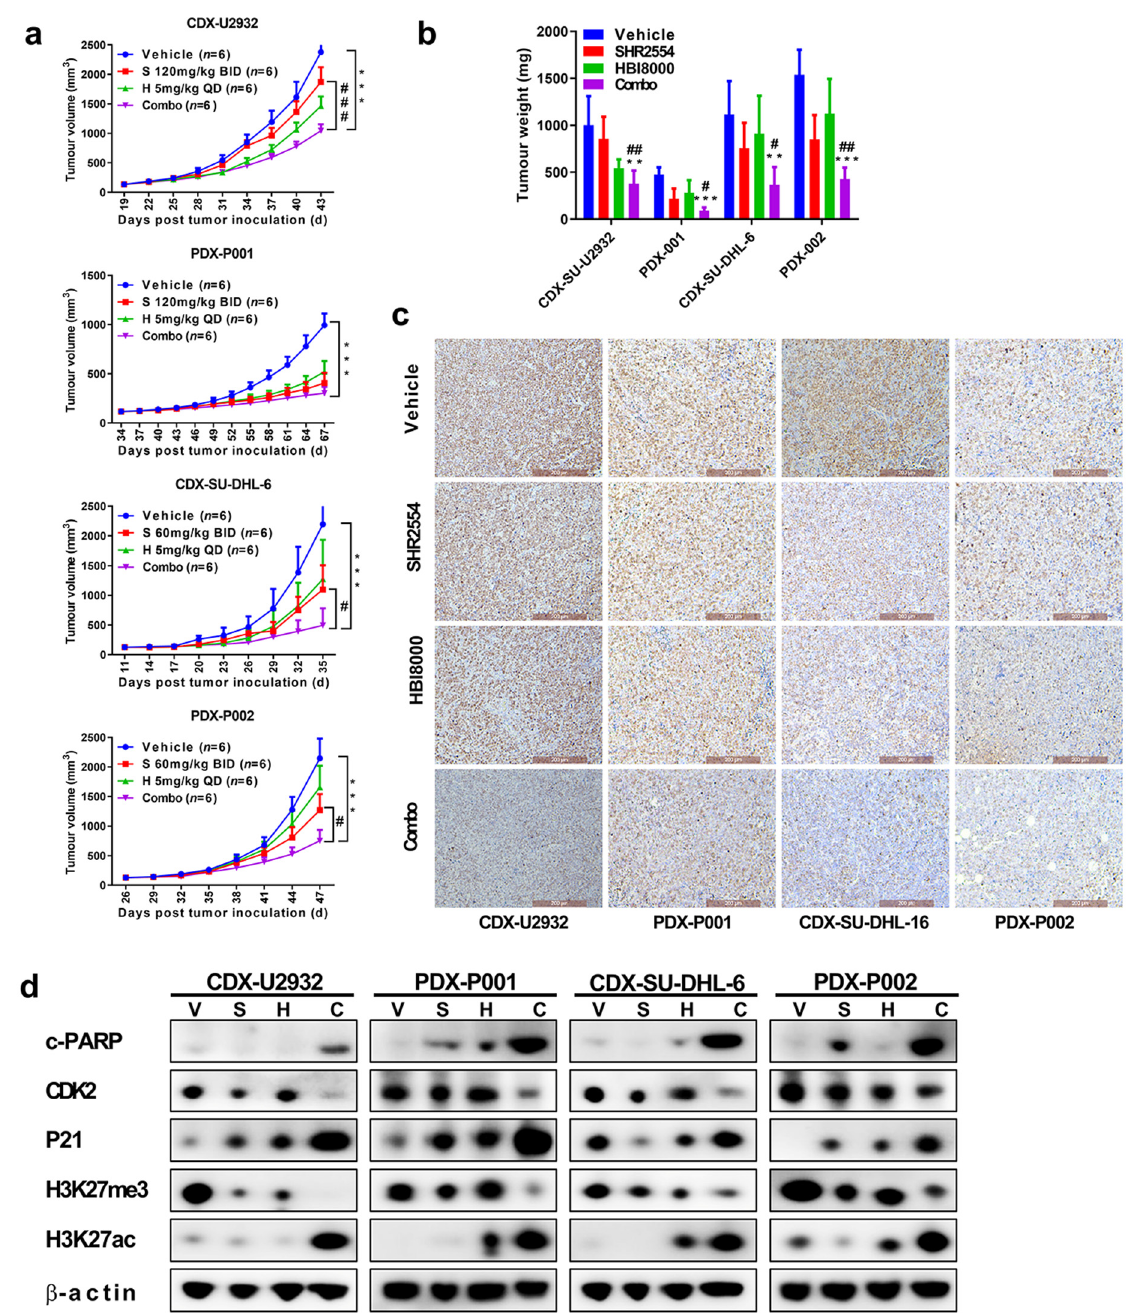
Figure 5. Combination of SHR2554 and HBI8000 exhibited synergistic anti-tumor effect in DLBCL models in vivo. Four DLBCL-derived xenograft models (CDXs: SU-DHL-6 and U2932; PDXs: PDX001-EZH2 WT and PDX002-EZH2 Y641N) were used to assess the anti-tumor activity of drug combination in vivo. ( a ) Tumor size curves derived from four models. ( b ) Tumor weight derived from four models. ( c ) Representative immunohistochemistry staining of Ki67 is shown (Scale bar 200 µ M). ( d ) Tumor tissues from four models were used to evaluate cell cycle, apoptosis and histone modification-related pathway by Western blot. Detailed information about Western Blot can be found at supplementary materials. ** p < 0.01, *** p < 0.001, # p < 0.05, ## p < 0.01, ### p < 0.001, compared with vehicle